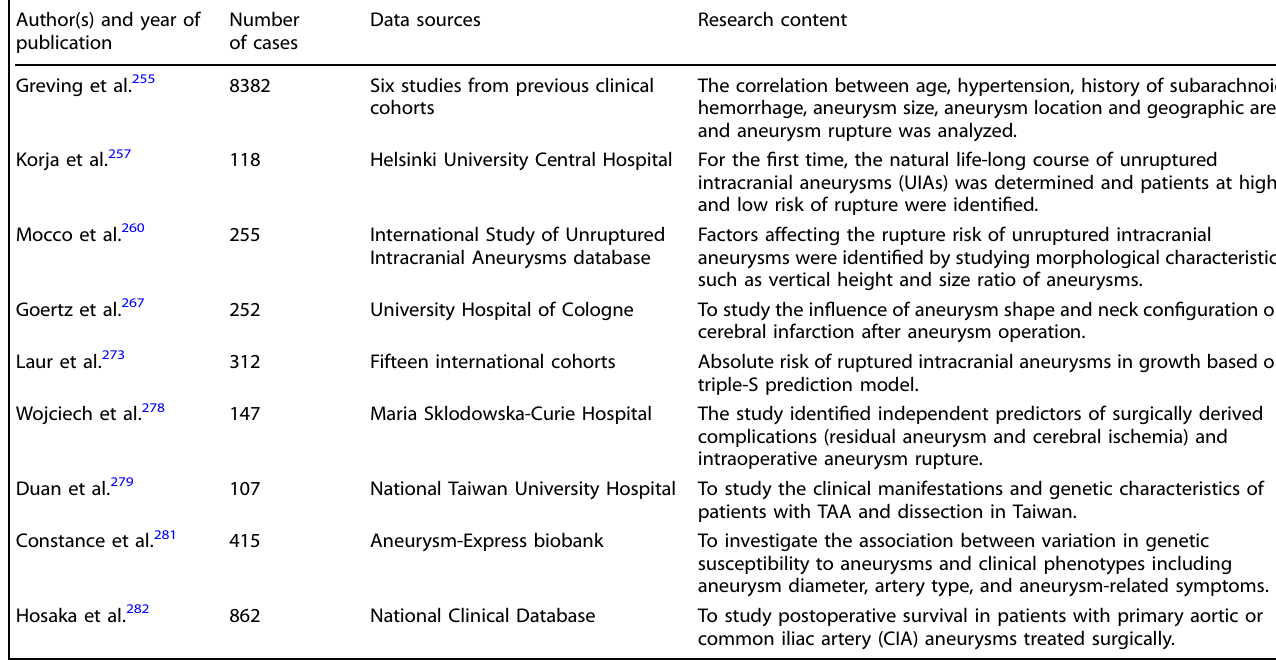
Table 1. Summary of aneurysm-related clinical